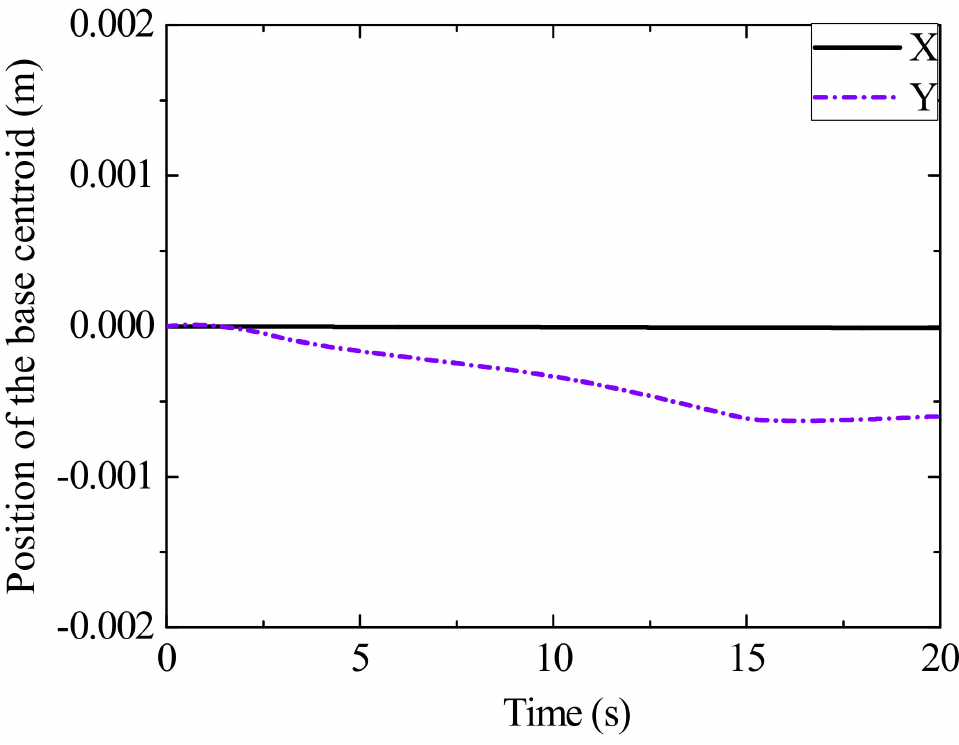
Figure 10. Position of the base centroid in the preassembly stage.